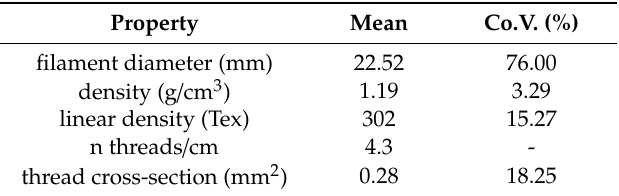
Table 1. Flax textile properties. Co.V.: Coefficient of variation.